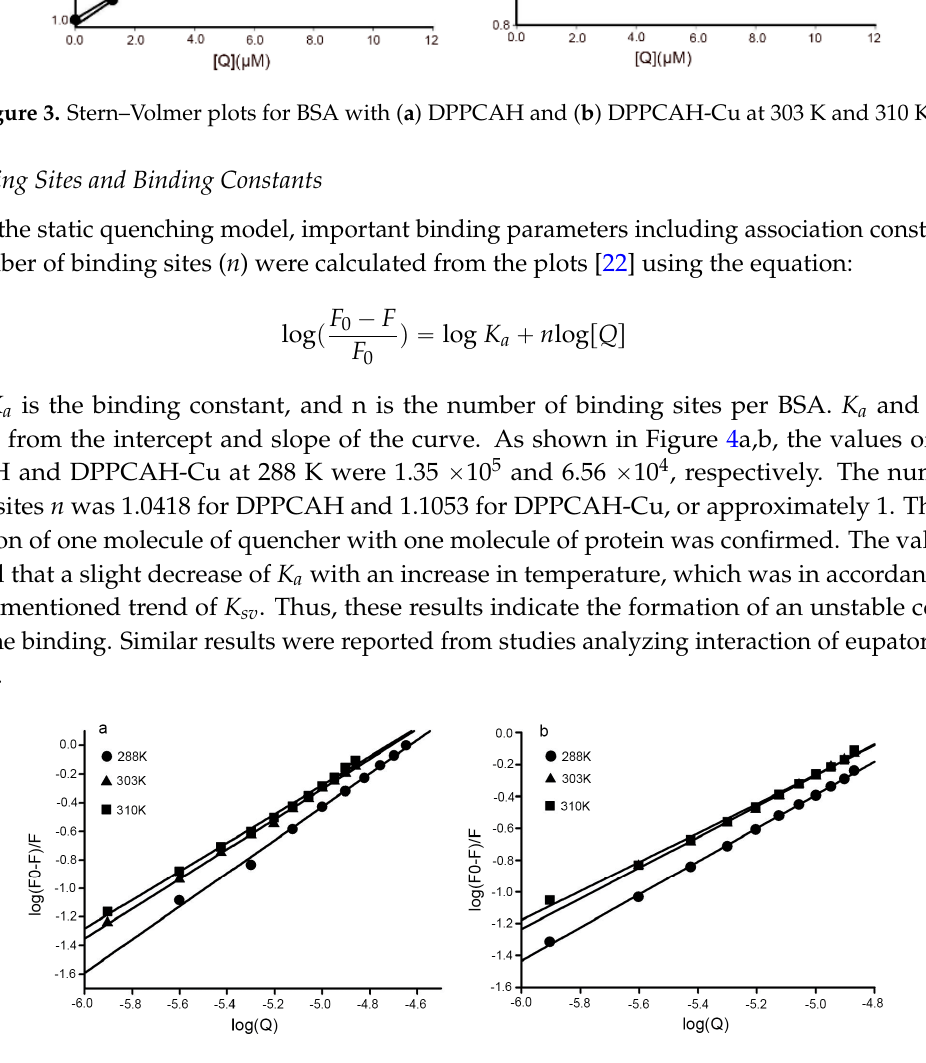
Figure 4. Plots of log [(F 0 − F)/F] vs. log [Q] for ( a ) BSA-DPPCAH and ( b ) BSA-DPPCAH-Cu systems at three different temperatures; C BSA = 10 μ M; pH = 7.2 (10 mM Tris-HCl).